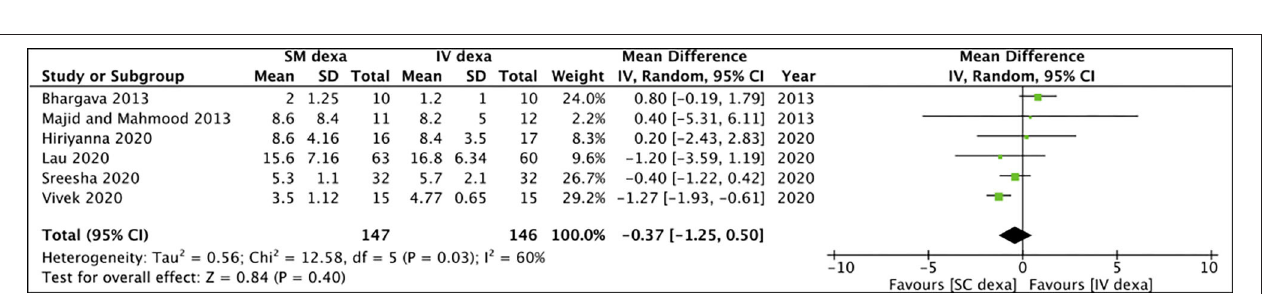
FIGURE 6 | Meta-analysis of early trismus between SM and IV dexamethasone (dexa) for third molar surgeries.